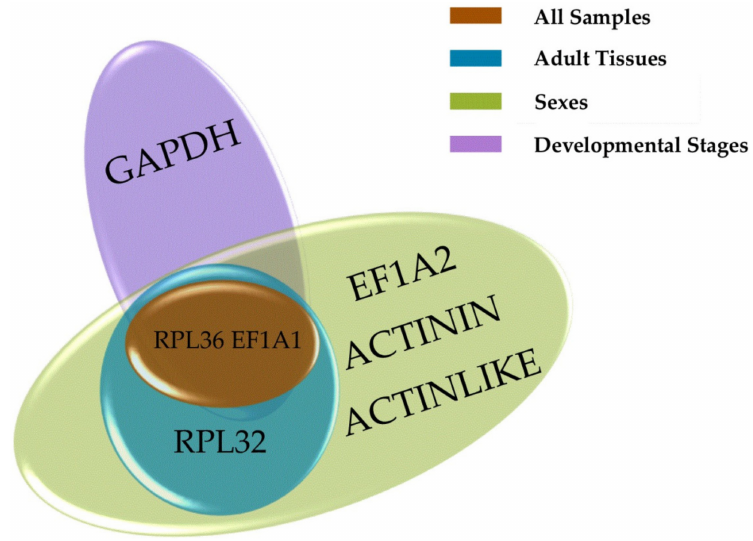
Figure 3. Venn diagrams showing the most stable genes identified by geNorm. The most stable genes were identified using the data under the different conditions. Each circle with a distinct color represents a different condition.